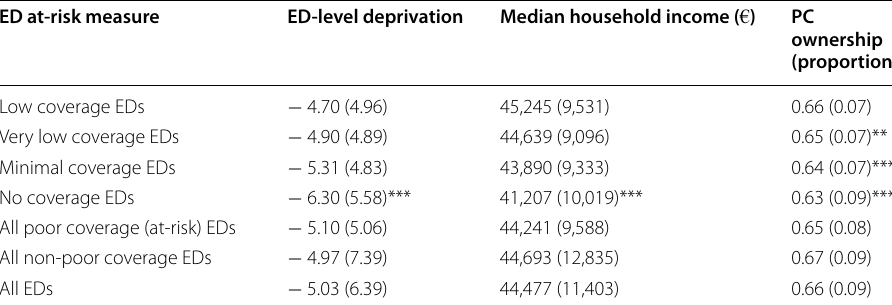
Table 3 Socioeconomic profile of at-risk electoral divisions